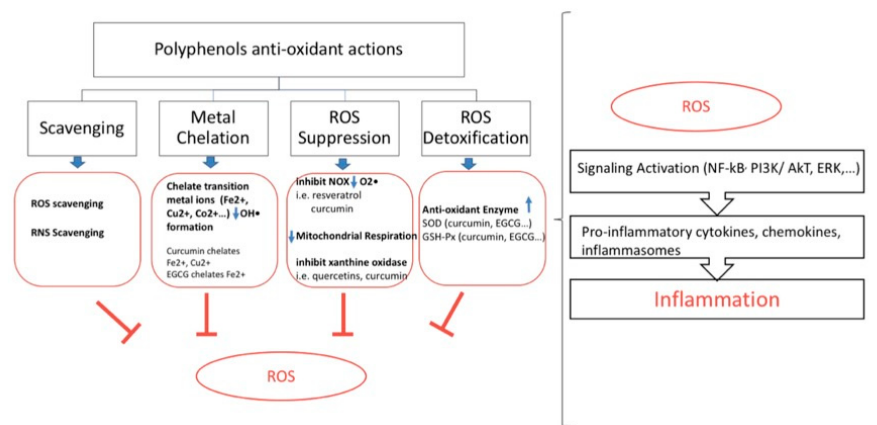
Figure 2. Key polyphenolic anti-oxidant actions in relation to anti-inflammation. Polyphenols scavenge radicals, chelate metal ions, inhibit ROS production and promote ROS detoxification. On the right panel ROS contribution to inflammation. ROS: reactive oxygen species; RNS: reactive nitrogen species; NOX: NADPH oxidase; SOD: superoxide dismutase; GSH-PX: glutathione peroxidase; ERK: extra-cellular signal regulated kinases; PI3K/AkT: phosphatidylinositide 3-kinases/protein kinase B; EGCG: epigallactocatechine gallate.